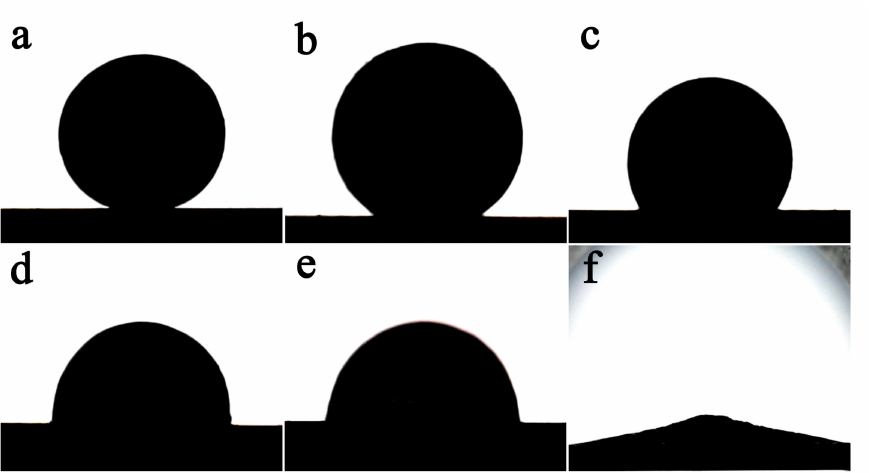
Figure 4. The wettability of molten aluminum on the two kinds of sample at different temperatures. Without Al film deposited sample: ( a ) 700 ◦ C; ( b ) 800 ◦ C; ( c ) 900 ◦ C; ( d ) 1000 ◦ C; ( e ) 1100 ◦ C; with Al film deposited: ( f ) 700 ◦